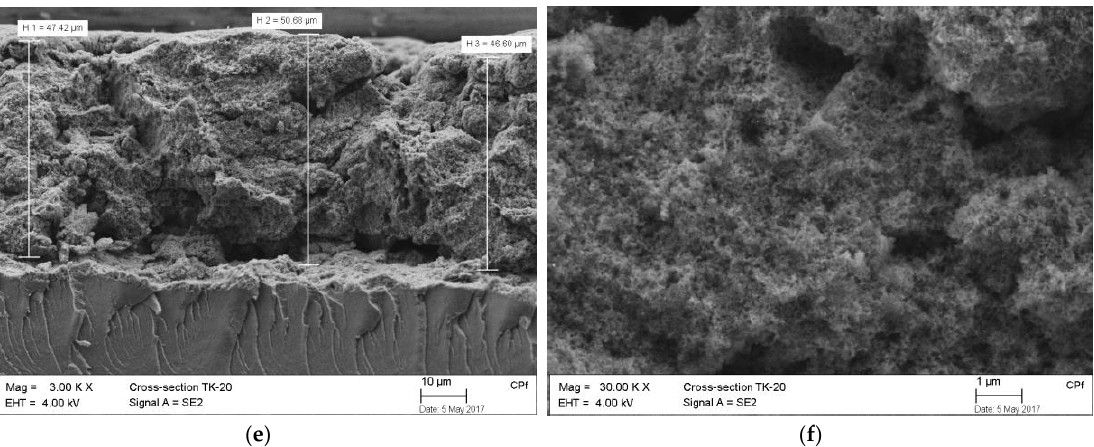
Figure 8. SEM images of the cross section of the MEAs, for Pt/CB ( a , b ), Pt/GC ( c , d ), and Tanaka ( e , f ) catalysts.